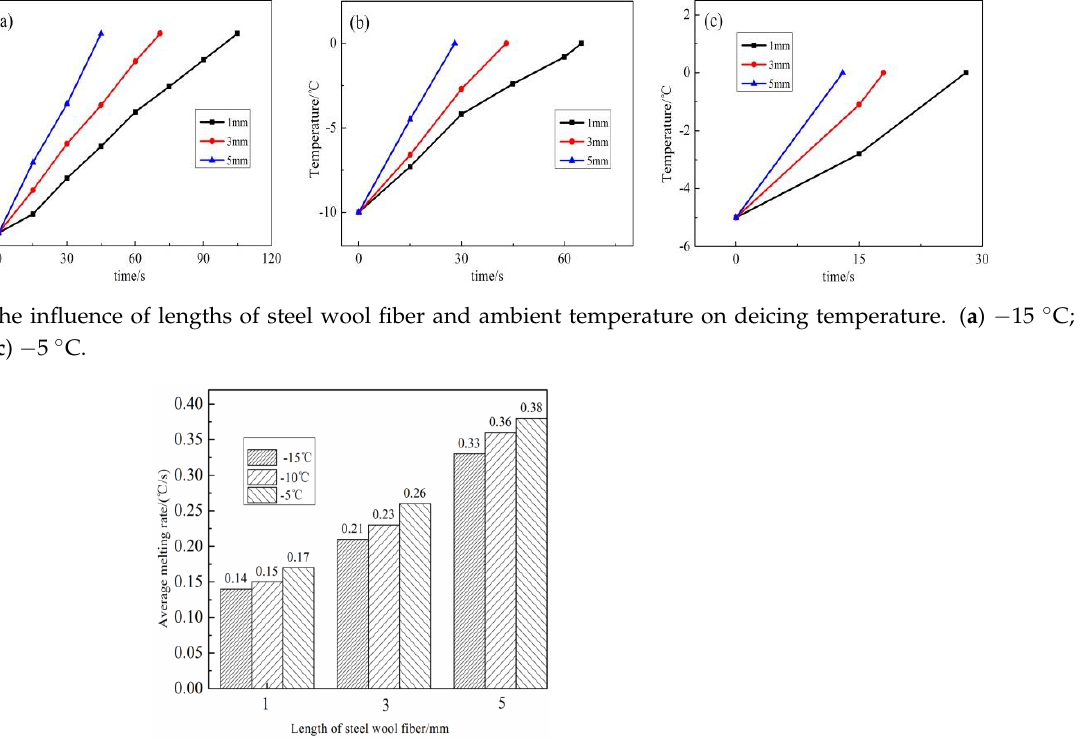
Figure 15. The influence of lengths of steel wool fiber and ambient temperature on average deicing